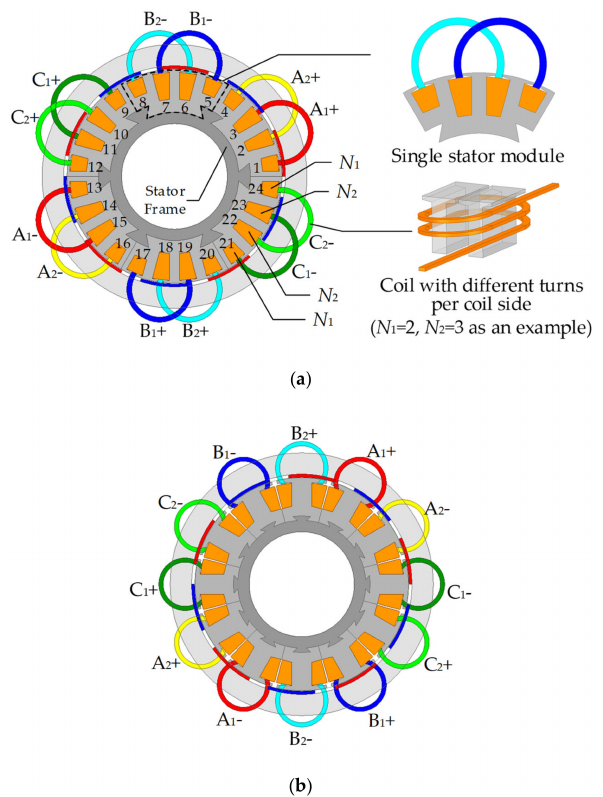
Figure 1. Machine topologies. ( a ) Proposed modular machine with special dual three-phase two-slot pitch winding (DTP-TSPW); ( b ) conventional modular machine with DTP-fractional-slot concentrated winding